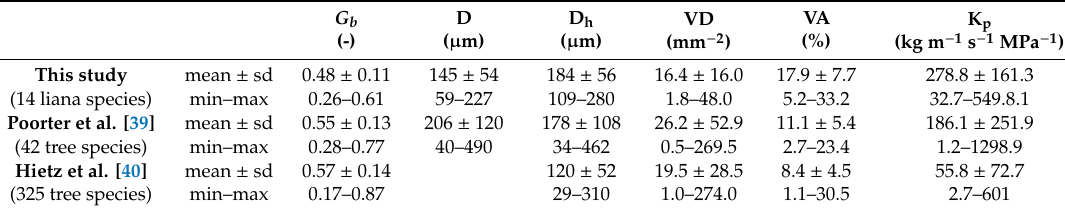
Table 2. Comparison between species-aggregated variable statistics from this study and tropical trees from Poorter et al. [39] and Hietz and colleagues [40]. Di ff erences between the numbers in Tables 1 and 2 originate from the aggregation at the species level. G b = basic specific gravity, D = mean vessel diameter, D h = hydraulically weighted mean diameter, VD = vessel density, VA = vessel area fraction, K p = maximum stem